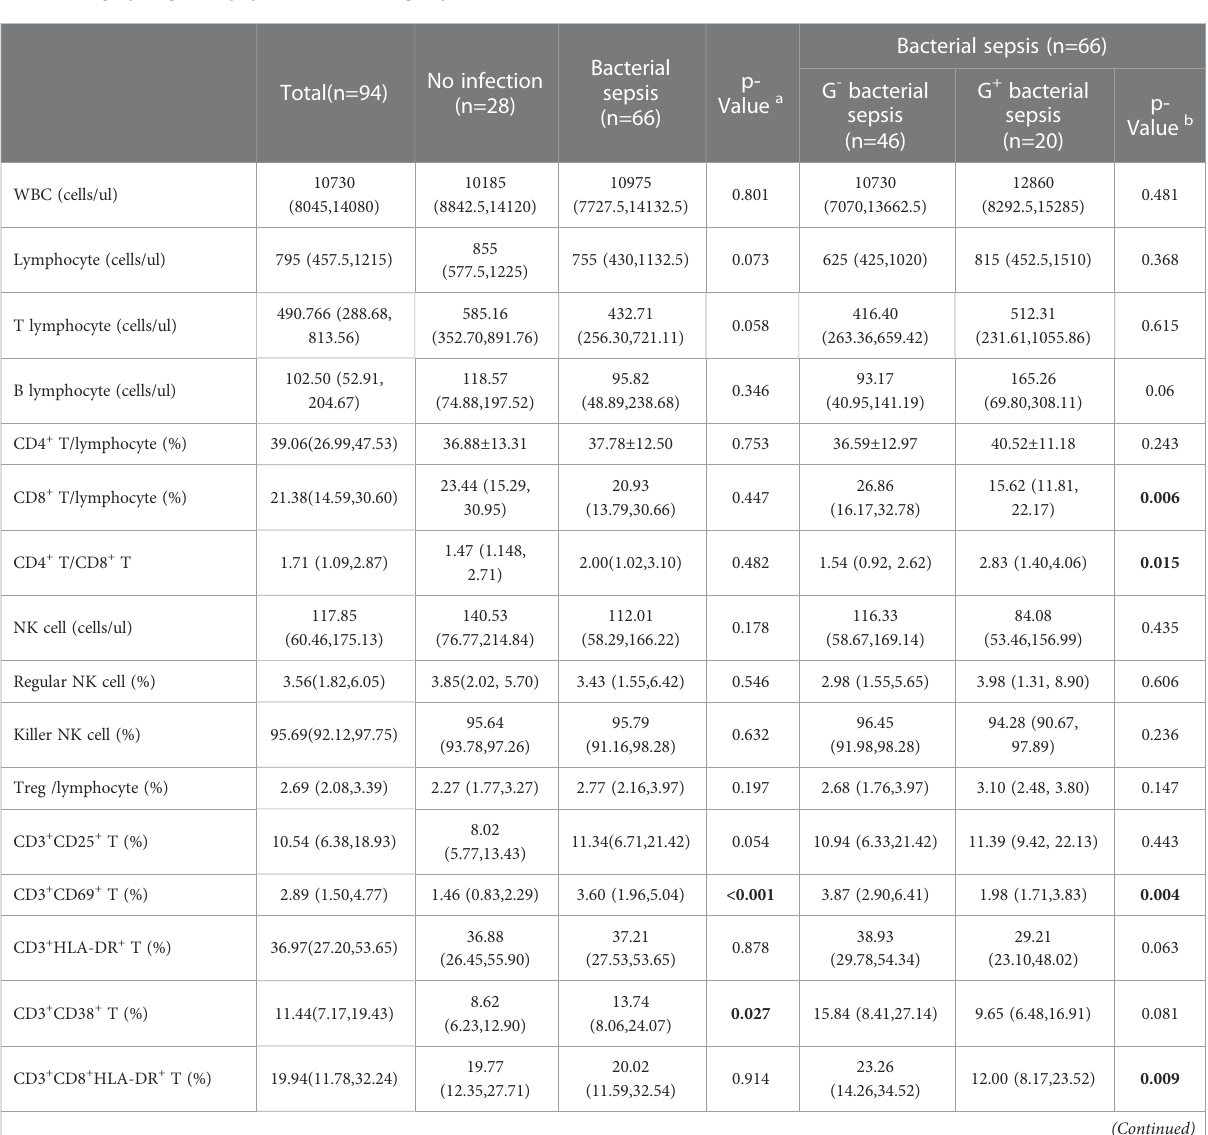
TABLE 4 T lymphocyte subpopulation of critically ill